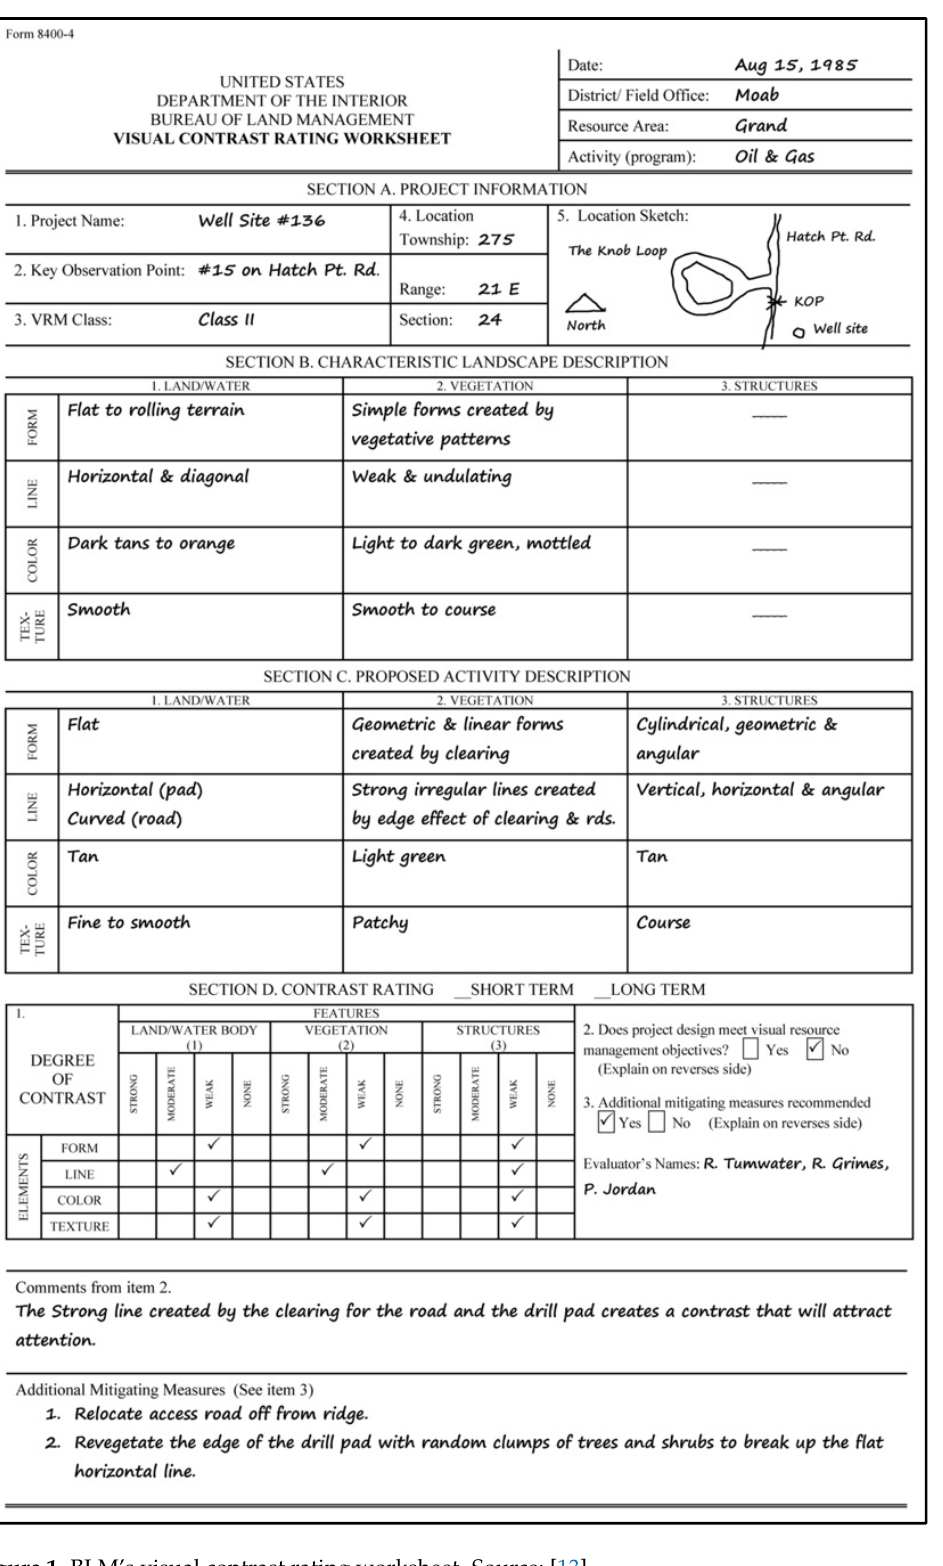
Figure 1. BLM’s visual contrast rating worksheet. Source: [13]. The actual “rating” is for the degree of contrast introduced by the activity-strong, moderate, weak, or none-with the form, line, color, and texture of the existing land/water, vegetation, and structures. Factors to be considered when determining the contrast